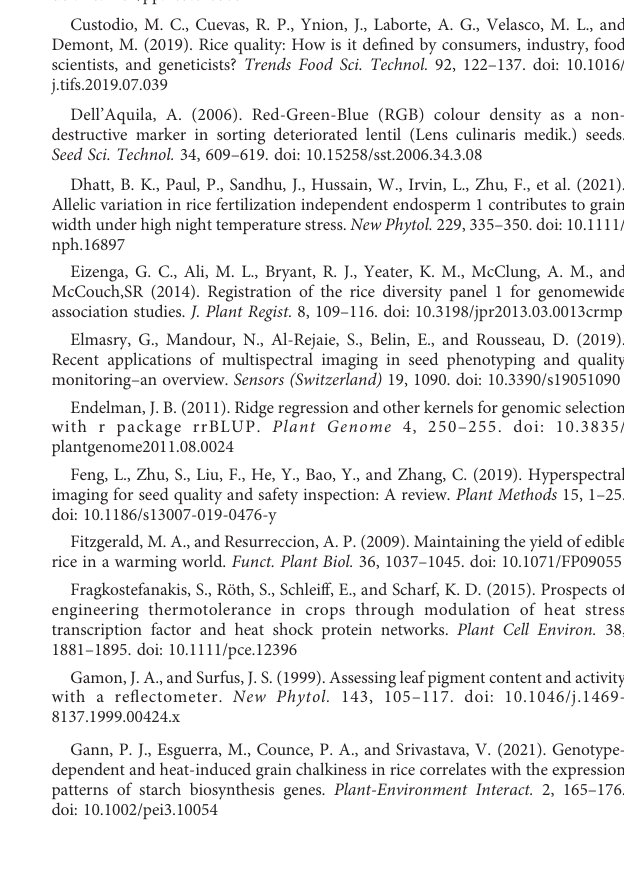
SUPPLEMENTARY TABLE S2 List of all primers used in the study. SUPPLEMENTARY TABLE S3 The number of grains used for each transgenic line for the phenotypic evaluation. SUPPLEMENTARY TABLE S4 Distribution of the ratio of red to green pixels (RG) under control and heat stress (HS) along with their percentage change (HS/Control) among the selected accessions from rice diversity panel 1. SUPPLEMENTARY TABLE S5 Details of signi fi cant SNPs and their associated locus (10kb upstream and downstream) under control and heat stress. SUPPLEMENTARY TABLE S6 Percentage reduction (%) of various grain parameters in wild-type, knockout and overexpression lines under heat stress. SUPPLEMENTARY TABLE S7 Genes positively and negatively co-regulated with OsCG5 identi fi ed from pairwise Pearson correlation analysis using the dataset from Chen et al.,